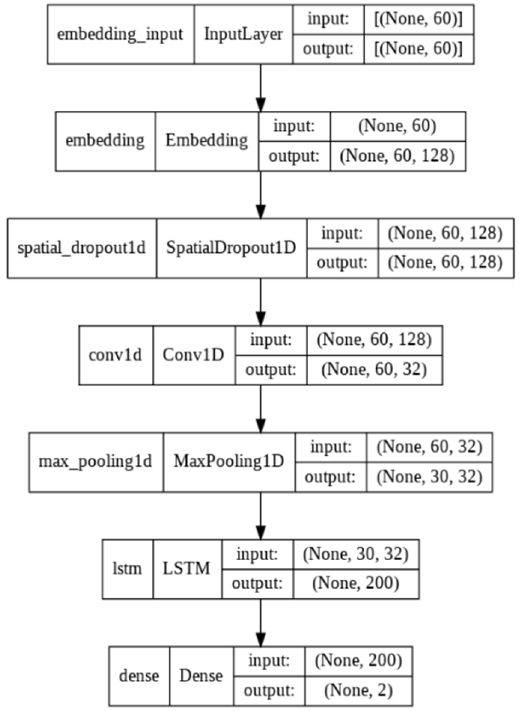
Figure 3. CLSTM model architecture.